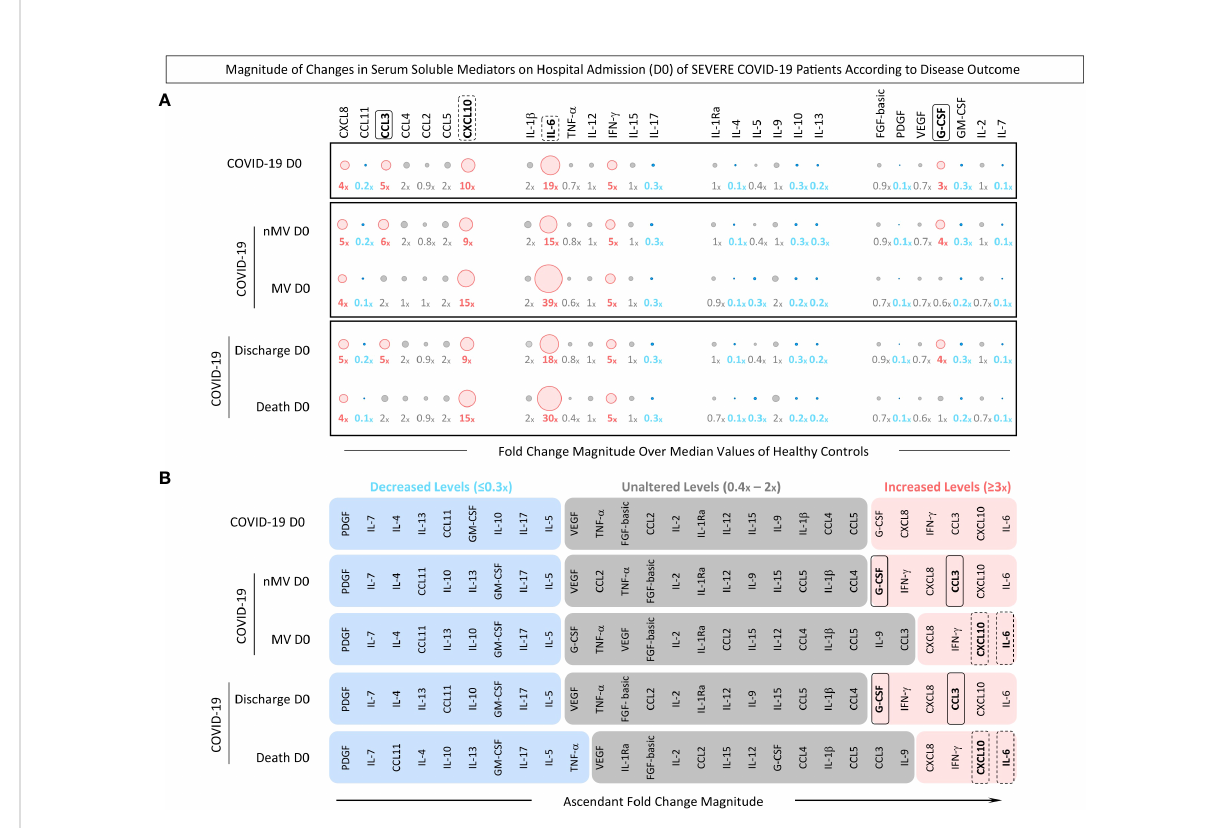
FIGURE 4 Magnitude of changes in serum soluble mediators on hospital admission (D0) of severe COVID-19 patients according to disease outcome . The fold change magnitude of serum chemokines (CXCL8, CCL11, CCL3, CCL4, CCL2, CCL5, CXCL10), pro-in fl ammatory cytokines (IL-1 b , IL-6, TNF- a , IL-12, IFN- g , IL-15, IL-17), regulatory cytokines (IL-1Ra, IL-4, IL-5, IL-9, IL-10, IL-13), and growth factors (FGF-basic, PDGF, VEGF, G-CSF, GM-CSF, IL-2, and IL-7) were calculated COVID-19 patients (n=82), further categorized into subgroups according to disease outcome, referred to as: Non-Mechanical Ventilation (nMV, n=71) vs Mechanical Ventilation (MV, n=11) and Discharge (n=75) vs Death (n=7). Serum soluble mediators were measured by high-throughput multiplex bead array as described in Material and Methods. The results are presented as the proportion of levels observed for each COVID-19 patient at admission (D0) divided by the median values reported for non-infected pre- pandemic Healthy Controls (HC, n=164). (A) Orbital graphs of fold change magnitudes underscore the attributes with decreased ( ≤ 0.3x, blue), unaltered (0.4-2x, gray) or increased levels ( ≥ 3x, pink) in relation to the median values observed in HC. (B) Ascendant signatures of fold change magnitudes were assembled to identify serum soluble mediators of good (nMV and Discharge, continuous rectangles) or poor prognosis (MV and Death, dashed